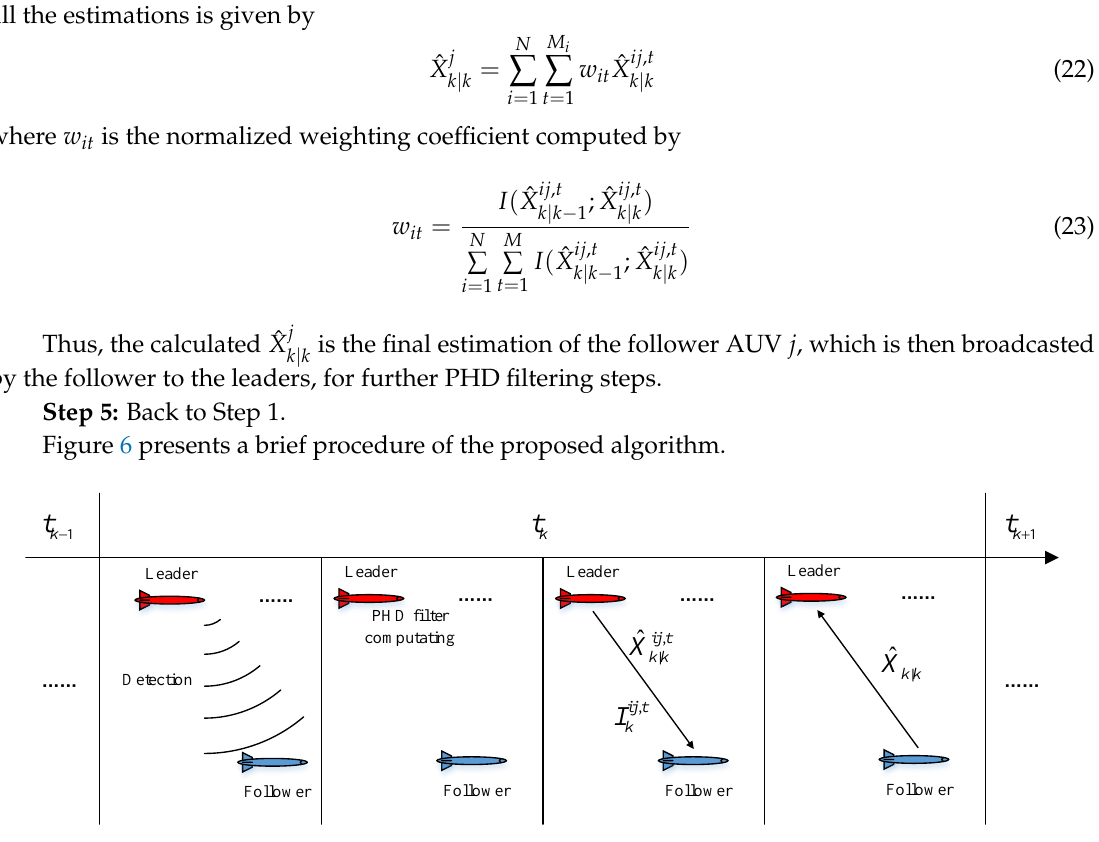
Figure 6. Working procedure of the proposed algorithm. PHD: Probability Hypothesis